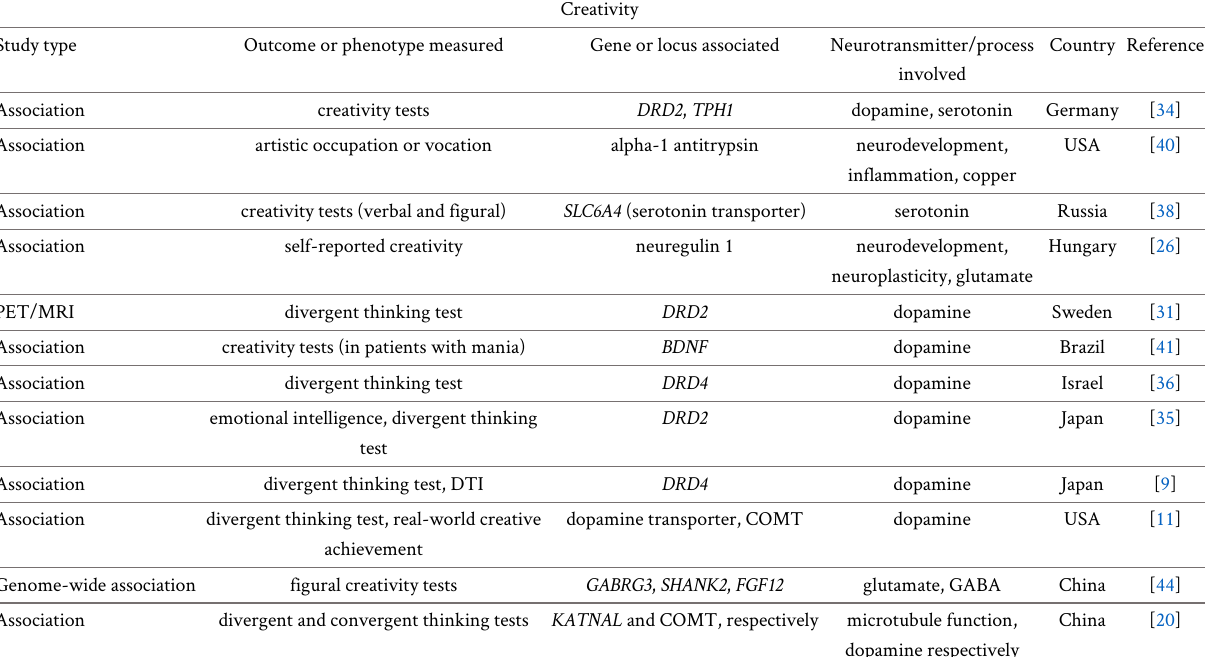
Table 1. Summary of published studies examining the genetic background of